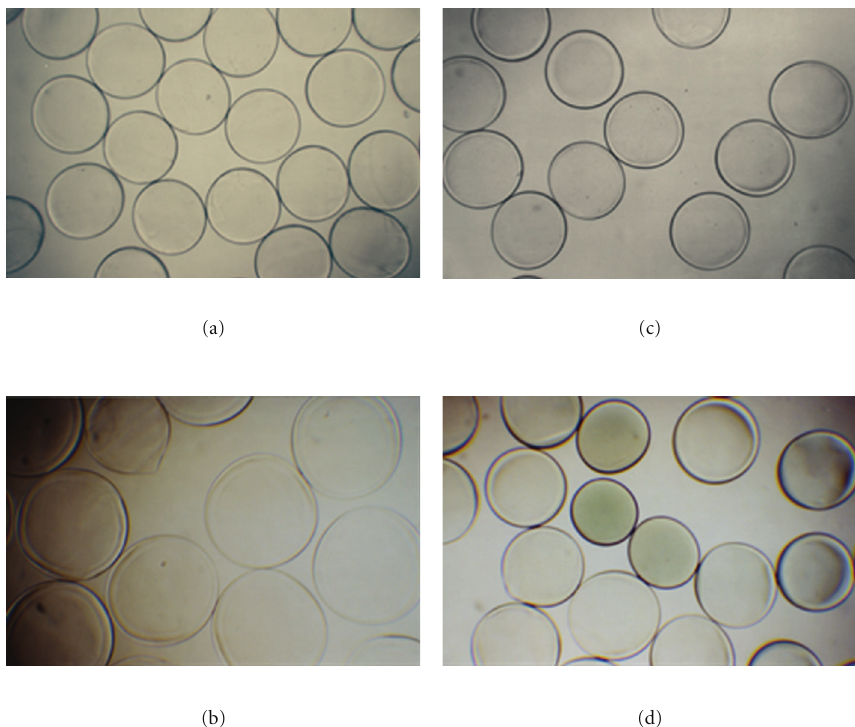
Figure 5: Microphotographs of the AC (a), (b), and GCAC (c), (d) microcapsules before (a), (c), and after (b), (d) chelation by sodium citrate (50mg/mL) for 24 hours. Original magnifications: 35 × .